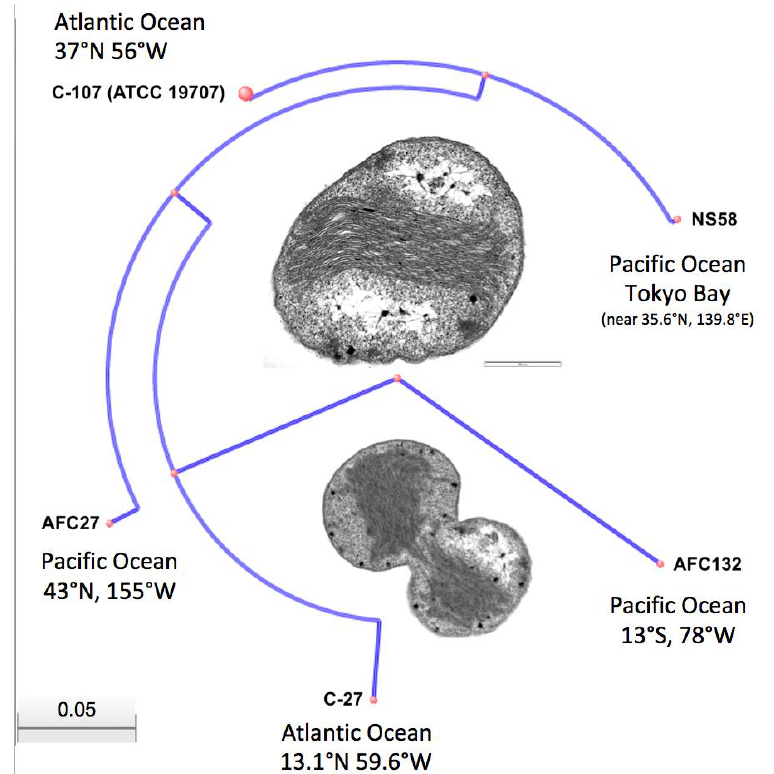
Figure 4. Dendrogram based on NCBI genomic BLAST analysis. Inserts show Transmission Electron Micrographs (TEM) of resting and dividing cells of Nitrosococcus oceani type strain C-107. TEMs were generated in the Electron Microscopy facility, University of Wisconsin-Madison, as described previously